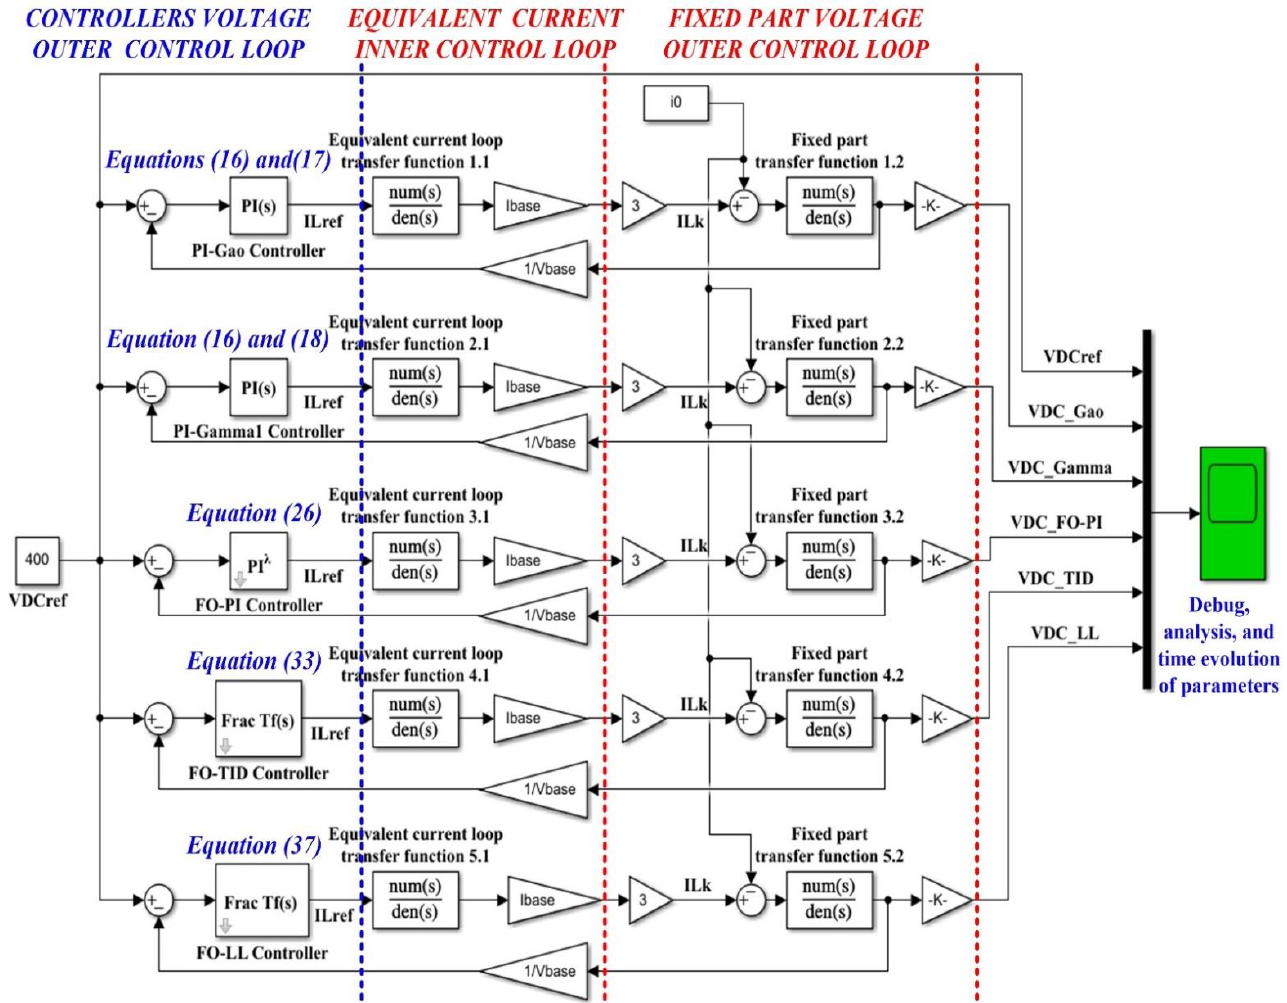
Figure 14. Matlab/Simulink implementation for the comparison of the control systems of power electronic converters using PI-Gao, PI-gamma, FO PI, FO TID, and FO lead-lag voltage controllers.